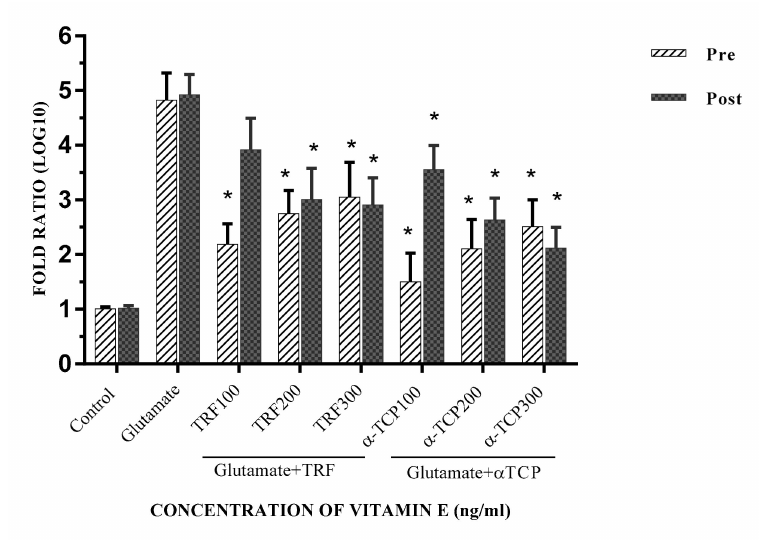
Figure 5. Gria2 mRNA expression in primary astrocytes with TRF and α -TCP pre-treatment against glutamate insult. Fold change of Gria2 normalized to ACTB mRNA expression. Data are the mean ± SEM of three independent experiments ( n = 3 in each experiment). * p < 0.05, TRF- and α -TCP-treated groups compared with the glutamate-treated group. Pre- and post-treatment with 100–300 ng/mL TRF and α -TCP significantly reduced the transcription levels of Gria2 in comparison to the positive control (glutamate).